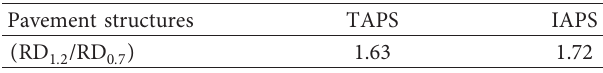
Table 12: Maximum rut depth ratio under different load pressures. Pavement structures